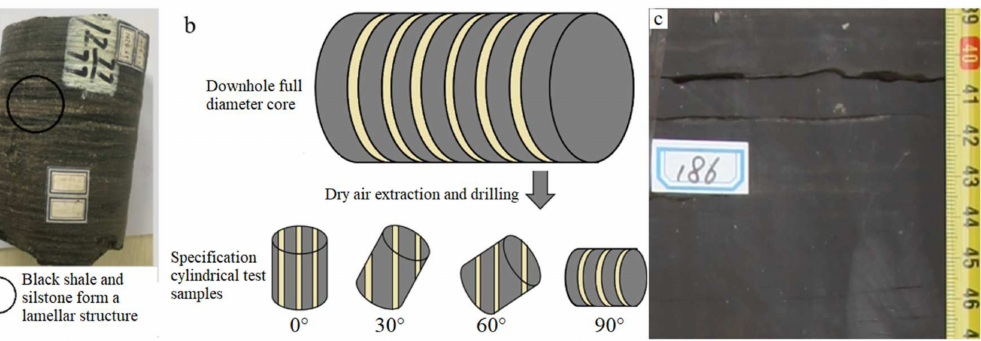
Figure 2. Lamellar shale sample preparation: ( a ) downhole full diameter lamellar shale sample with diameter = 102 mm; ( b ) schematic diagram of sample drilling; ( c ) downhole full diameter bedding shale sample with diameter = 102